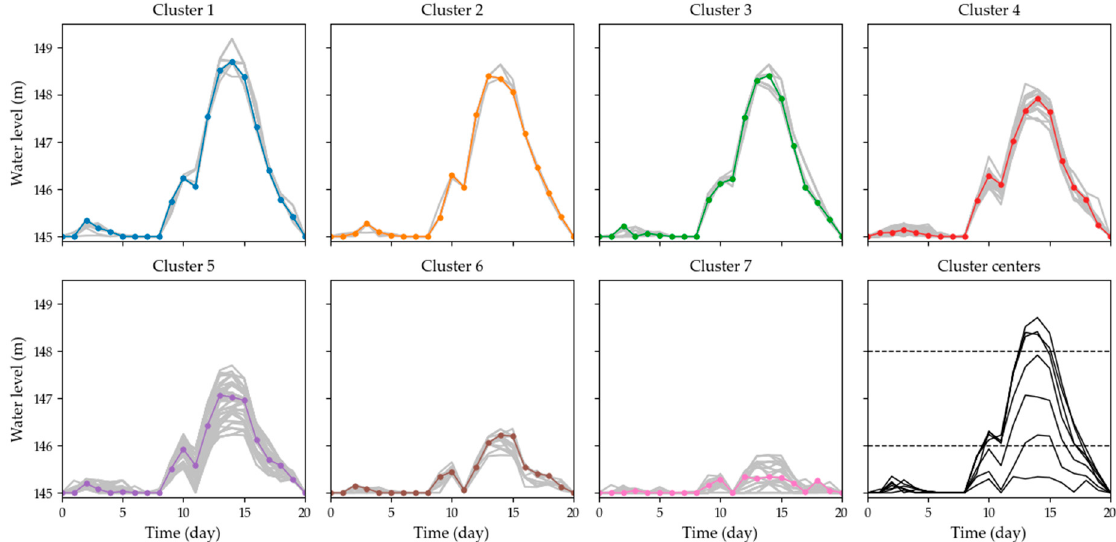
Figure 10. Clustering results on the reservoir operation processes via Mei–Wang fluctuation similarity measure (MWFSM). Clusters are drawn in each subfigure separately. The cluster centers are shown in the last subfigure.